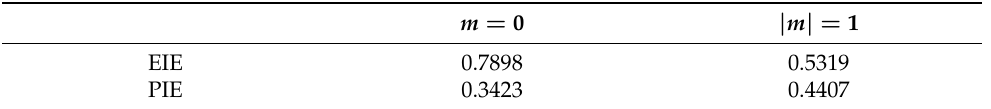
Table 5. Partial cross sections for the excitation into magnetic sub-levels of the 3 P 1 state for U 90 + in collision with an H 2 target at 218 MeV/u. The results are given in barns. m =